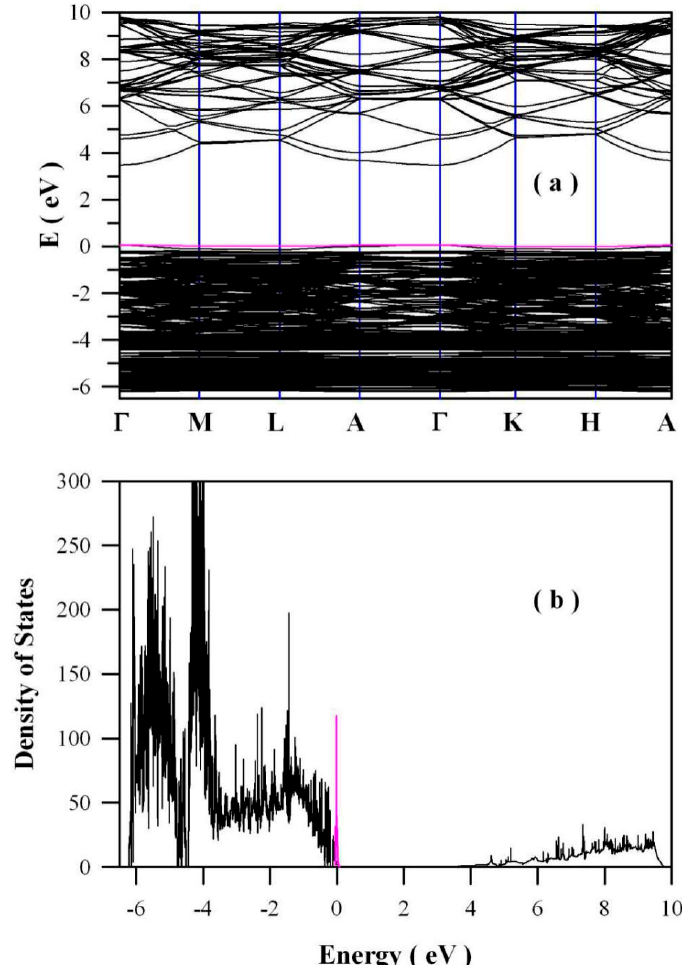
Figure 8. Band structures ( a ) and density of states ( b ) of zinc-deficient ZnO (i.e., Zn 0.98 O) via the density functional calculation.